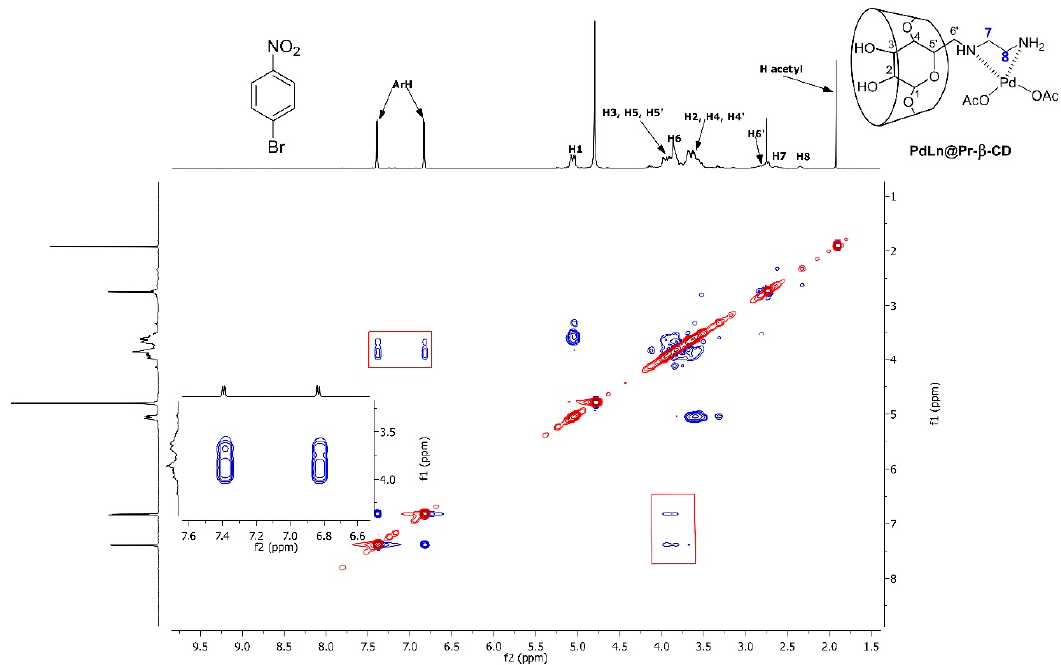
Figure. 6. 2D ROESY NMR spectrum (600 MHz) of the PdLn@Et ‐β‐ CD complex with BN. The solution Figure 6. 2D ROESY NMR spectrum (600 MHz) of the PdLn@Et- β -CD complex with BN. The solution contained deuterium oxide (D, 99.9%), BN (10 mM), and PdLn@Et ‐β‐ CD (10 mM). Mixing time: 400 contained deuterium oxide (D, 99.9%), BN (10 mM), and PdLn@Et- β -CD (10 mM). Mixing time: 400 ms.